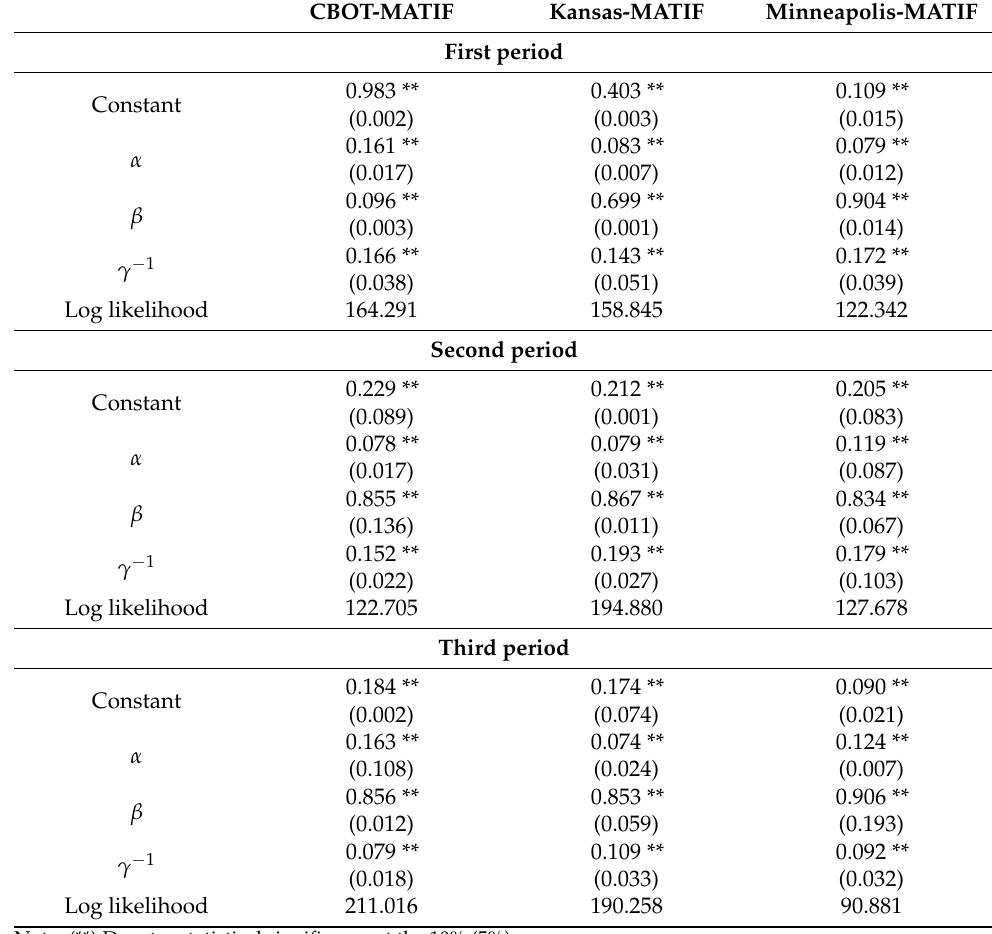
Table 12. Time varying Student’s t